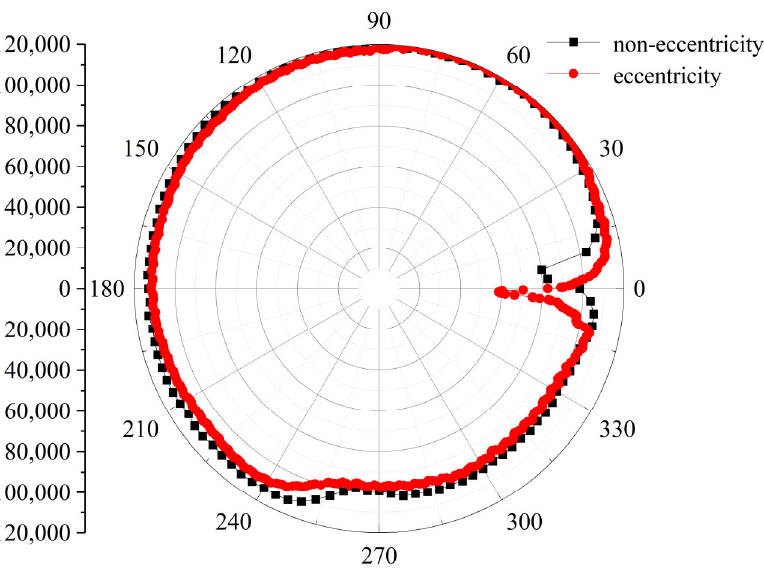
Figure 14. Impeller Outlet Pressure Comparison.